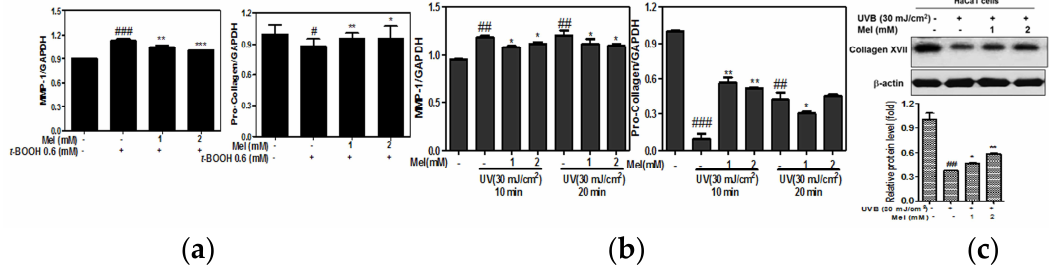
Figure 3. The melatonin attenuated the mRNA expression of MMP-1 and pro-collagen in t-BOOH or UVB induced HaCaT keratinocytes. ( a ) Cells were pretreated with melatonin for 24h and then with t-BOOH (0.6 mM) for 6h. mRNA expressions of MMP-1 and pro-collagen were analyzed by Real-Time PCR. Data represent means ± SD. *** p < 0.001, ** p < 0.01 and * p < 0.05 versus t-BOOH control, ### p < 0.001 versus normal control. ( b ) Cells were pretreated with melatonin for 24h and then irradiated by UVB (30 mJ/cm 2 ) for 10 min or 20 min. mRNA expressions of MMP-1 and pro-collagen were analyzed by Real-Time PCR. Data represent means ± SD. ** p < 0.01 and * p < 0.05 versus UVB control, ### p < 0.001 and ## p < 0.01versus normal control. ( c ) HaCaT cells were exposed to UVB (30 mJ/cm 2 ) for 10 min and subjected to Western blotting for collagen XVII and β-actin. Graphs represent quantitative data of protein expression adjusted by β-actin. Data represent means ± SD. ** p < 0.01 and * p < 0.05 versus UVB control, ## p < 0.01 versus normal control.